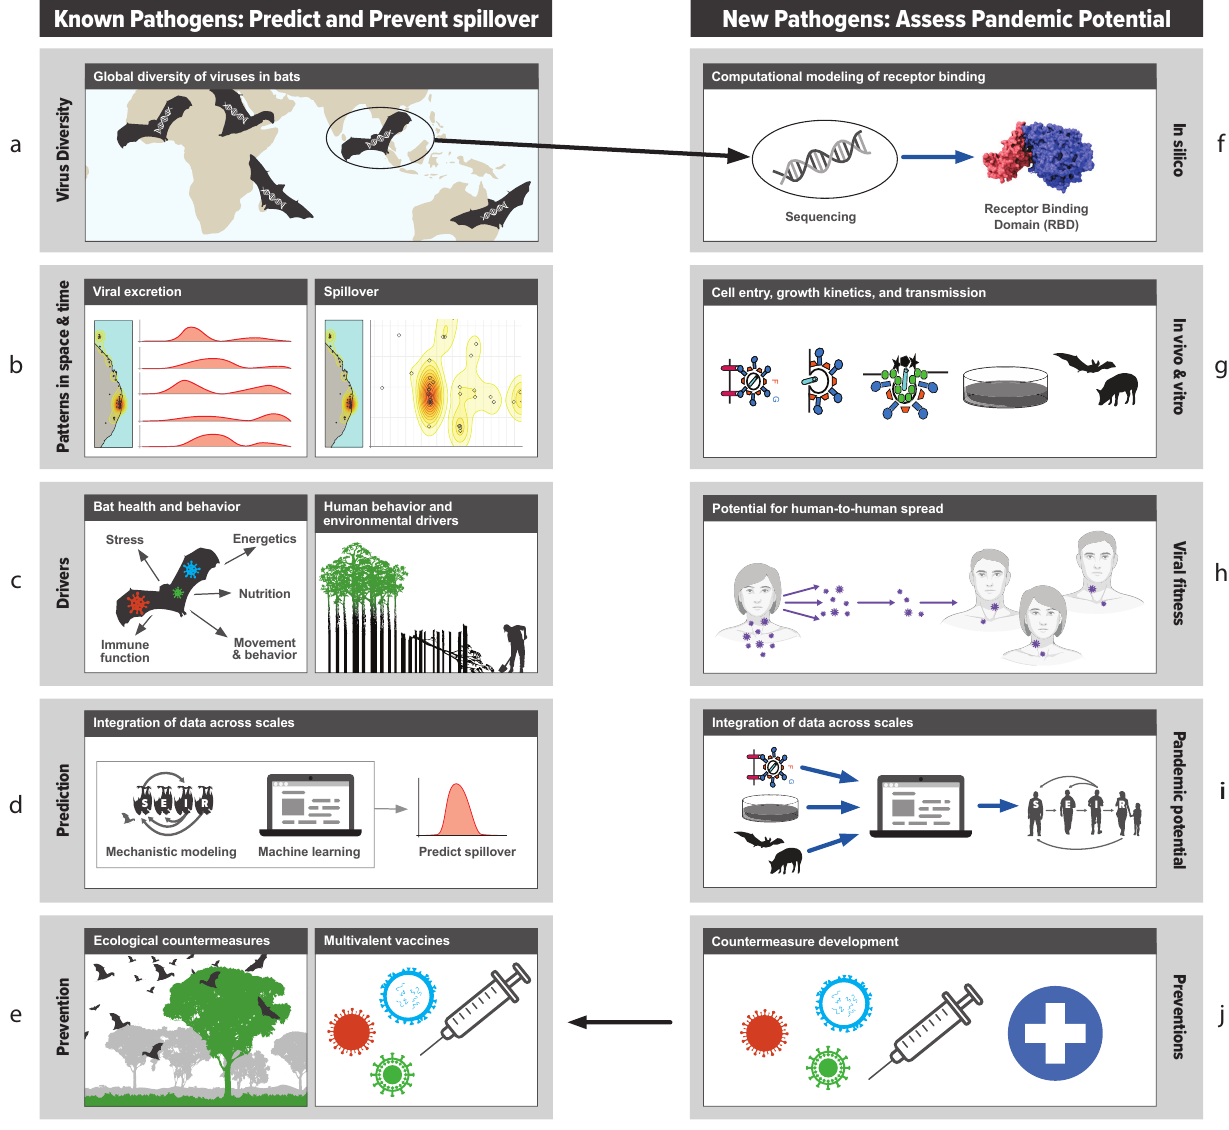
Figure 3. Transdisciplinary and convergent approach to studying pathogen spillover by Bat One Health (www.batonehealth. org, accessed on 25 June 2021). On the left side, ecological, physiological, and behavioral information is collected alongside host–viral dynamics ( a – c ). Data are integrated within models to make predictions ( d ) and to develop interventions to prevent spillover ( e ). On the right is a proactive means to assess pandemic potential of viruses by examining viral fitness in silico, in vitro, and in vivo ( f – j